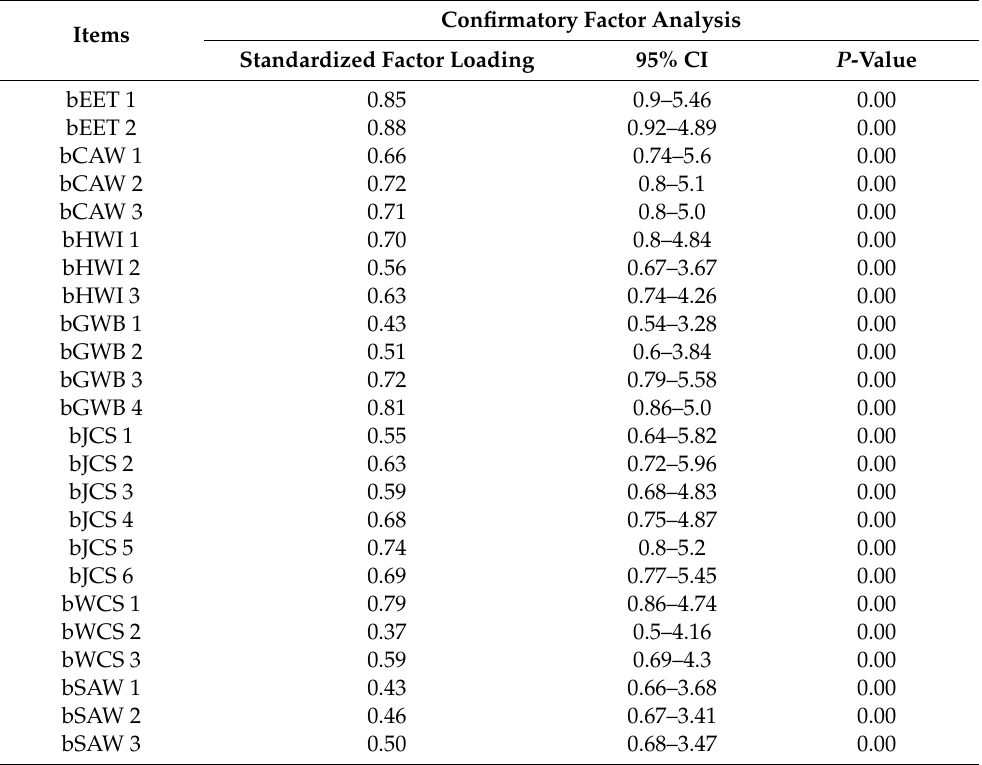
Table 3. Standardized factor loading based on confirmatory factor analysis of the brief